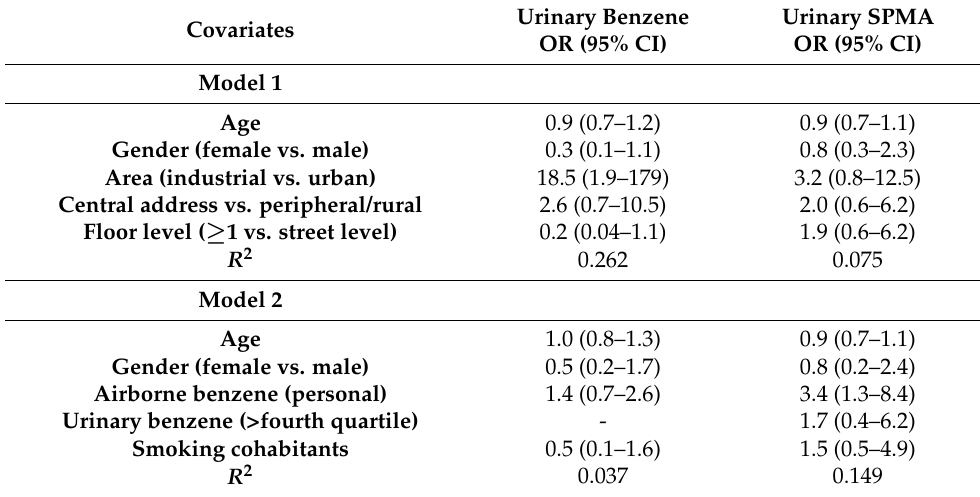
Table 6. Results of the logistic regression analysis with urinary benzene and urinary S-PMA above the upper quartile as the